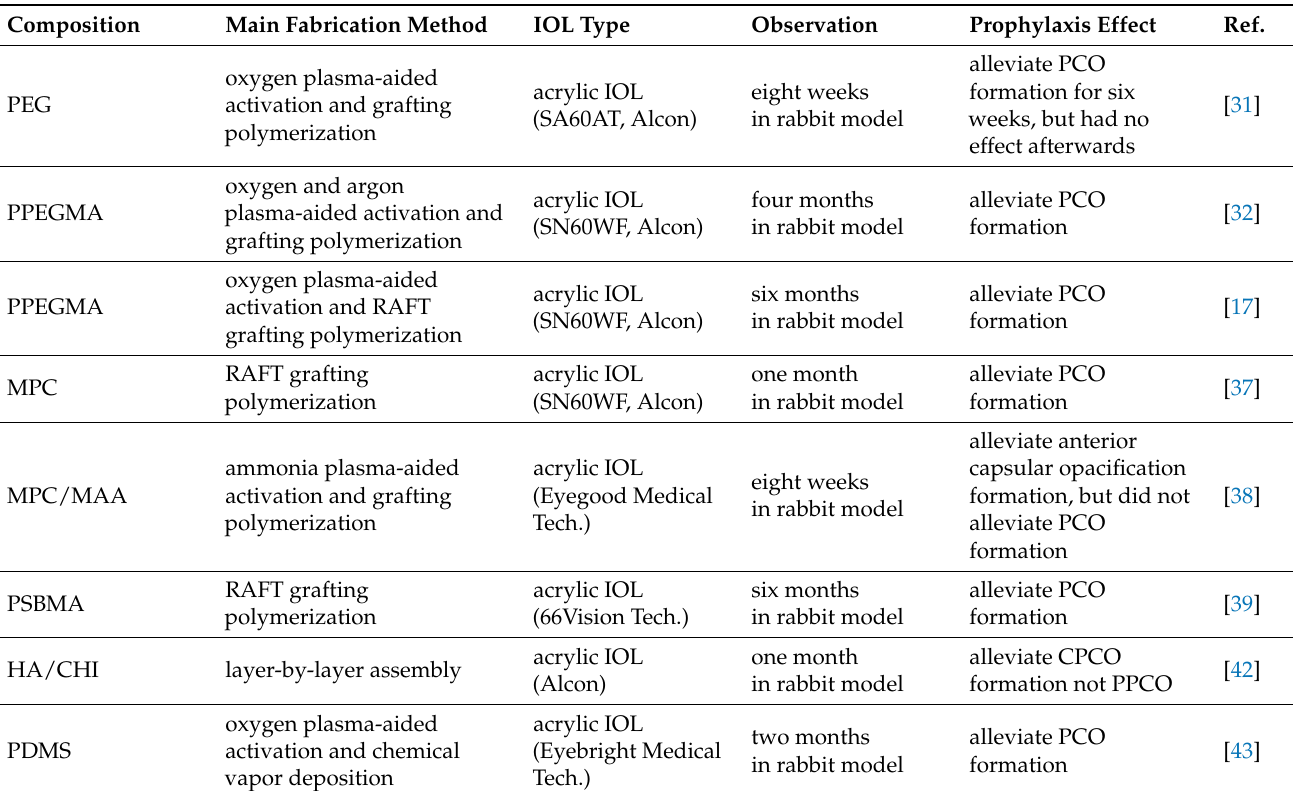
Table 1. Summary of reviewed literature of anti-biofouling IOLs for PCO prophylaxis with in vivo